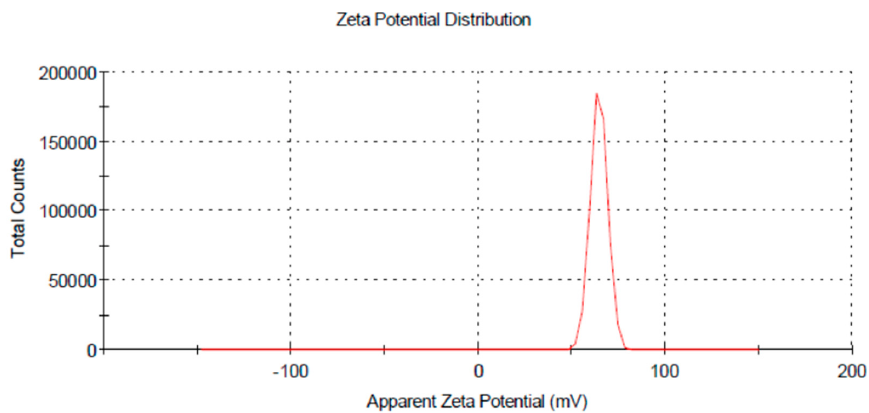
Figure 2. Zeta potential distribution average of chitosan nanoparticles.